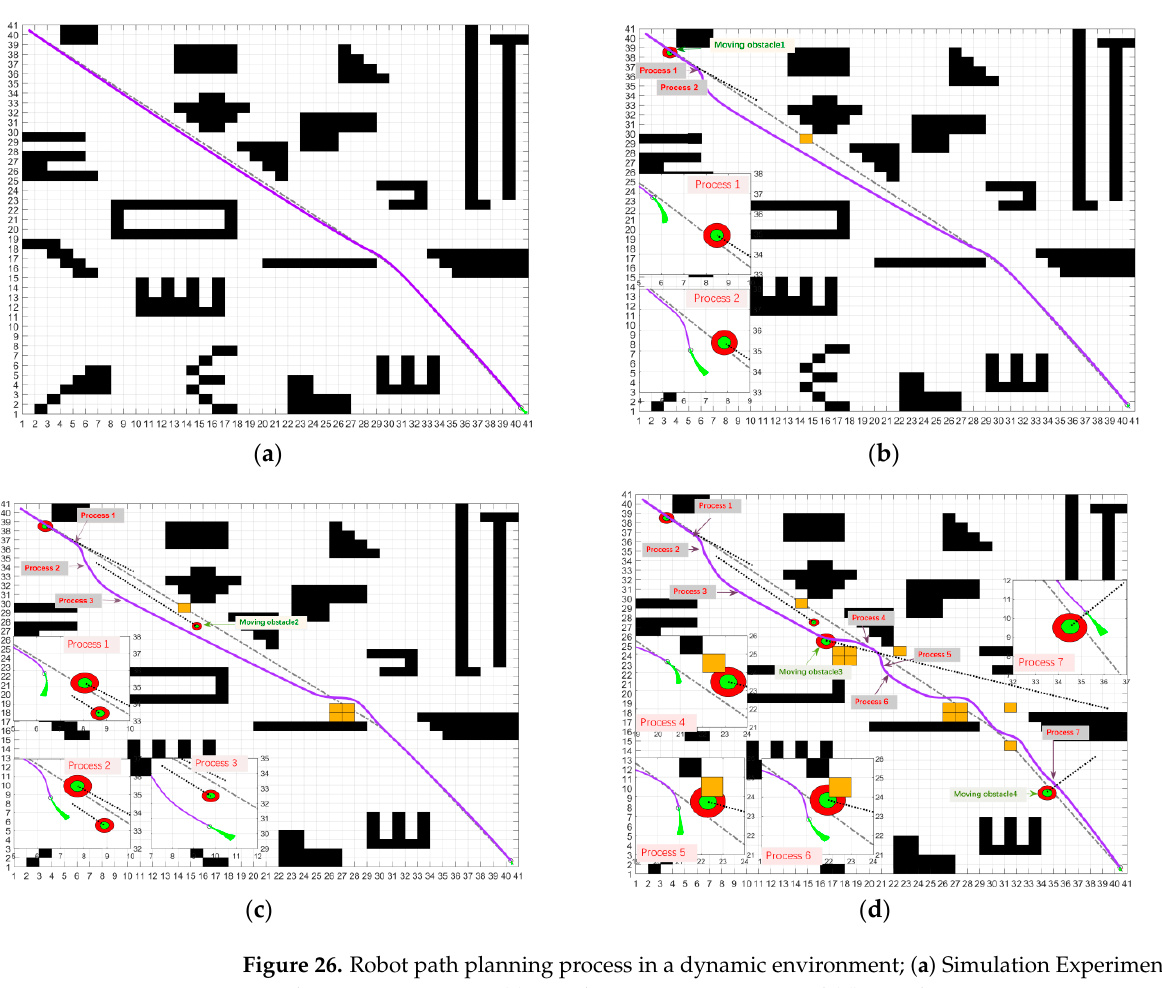
Figure 25. Variation of robot motion parameters in a dynamic environment 4; ( a ) Diagram of the robot’s linear and angular velocity variation; ( b ) Diagram of the robot’s angular variation.